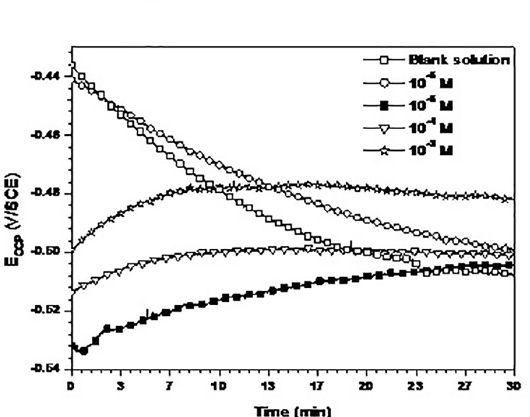
Figure 3 . Potentiodynamic polarization curves of mild steel in 1.0 M HCl containing different concentration of